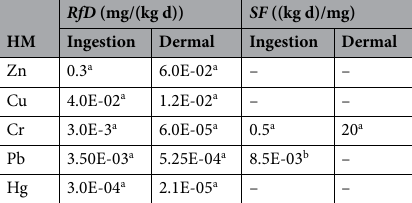
Table 2. Reference dose ( RfD ) and slope factor ( SF ) values of heavy metal(loid)s in soil by different exposure pathways used in health-risk assessment with Monte Carlo simulation. a Sun et al. 29 ; b USEPA 48